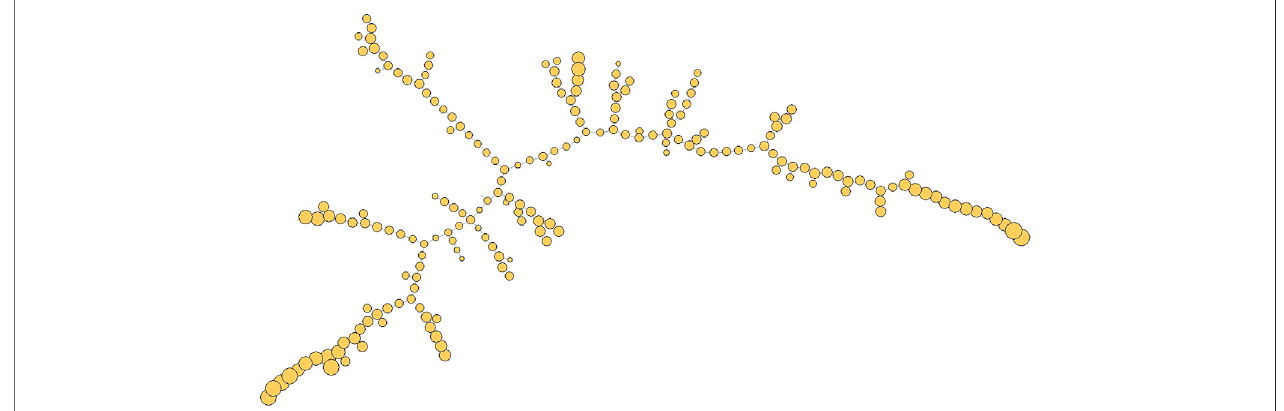
FIGURE 2 | Fundamental Network: Model 1, 200 stocks in 2009. Size of node is positively correlated to weighted degree and investment allocation.